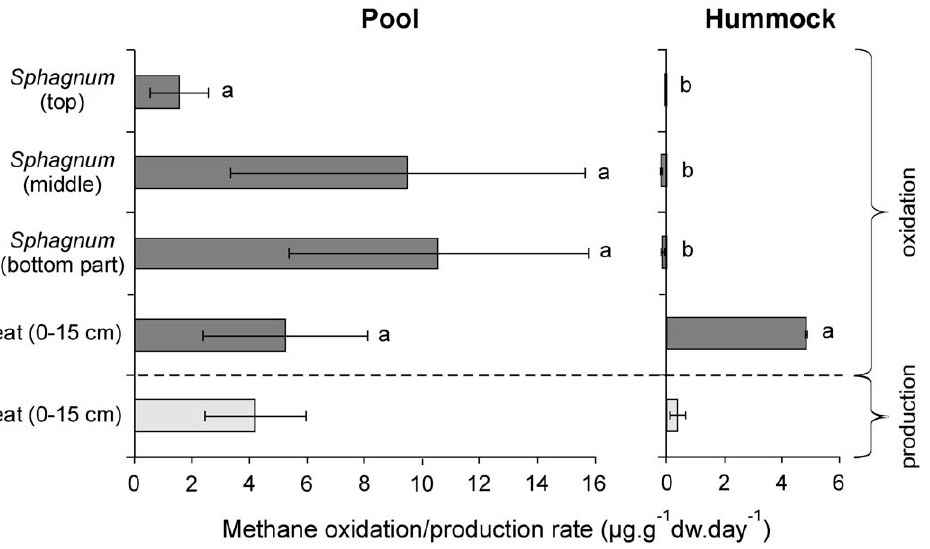
Figure 1. Potential methane oxidation rates (grey bars) and production rates (white bars). Sphagnum plants and peat from a pool-site and a hummock-site were analysed. Sphagnum plants were divided in three parts. Rates are expressed in m g.g dw 2 1 .day 2 1 and are means of triplicate incubations 6 s.d. Letters indicate statistically significant groups of data ( P , 0.05).